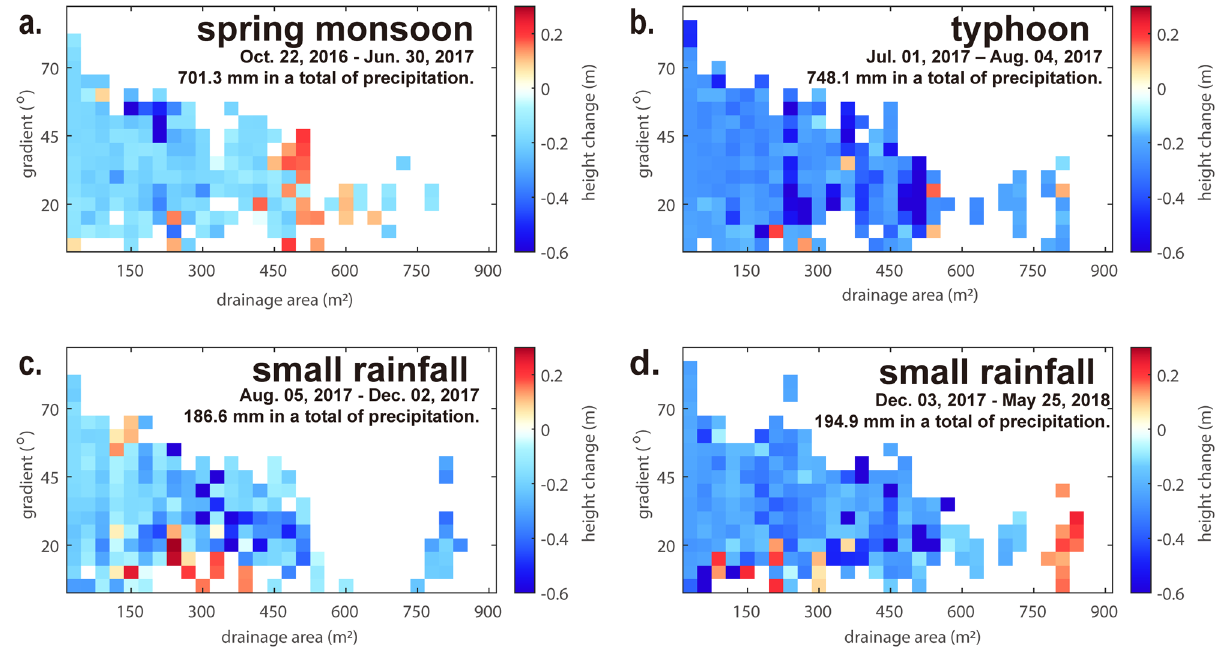
Fig. 2 Distribution of mean spatiotemporal erosion for the survey periods. a Oct. 22, 2016 – Jun. 30, 2017 (monsoon). b Jul. 01, 2017 – Aug. 04, 2017 (typhoons). c Aug. 05, 2017 – Dec. 02, 2017 (winter precipitation). d Dec. 03, 2017 – May 25, 2018 (winter precipitation). The color indicates the mean of height change, warm and cold colors represent positive and negative values, respectively (see